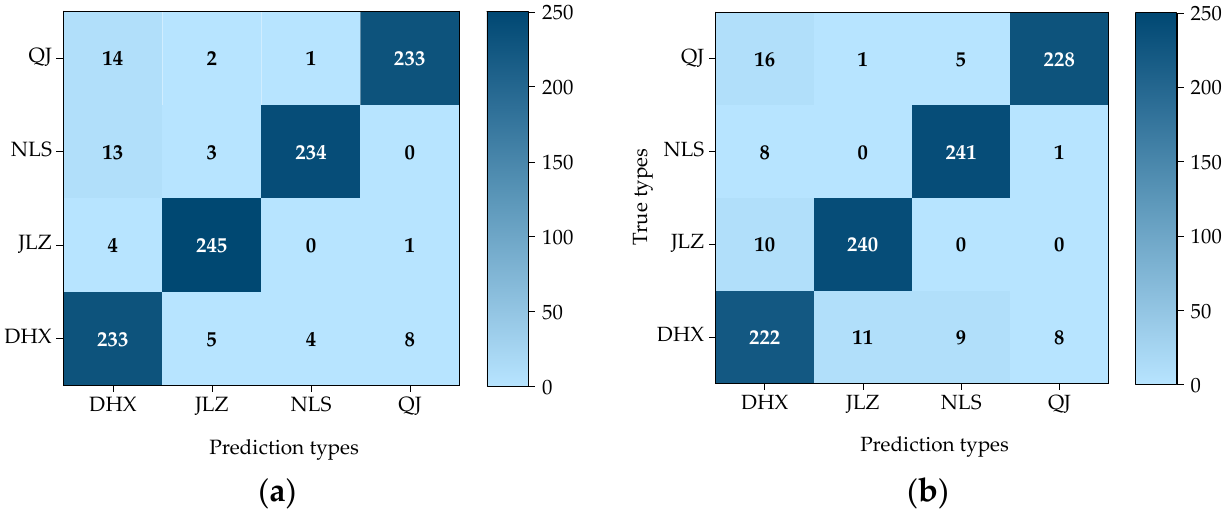
Figure 14. Confusion matrices in liquor experiments. ( a ) The confusion matrix obtained by XGBoost; ( b ) The confusion matrix obtained by LightGBM.